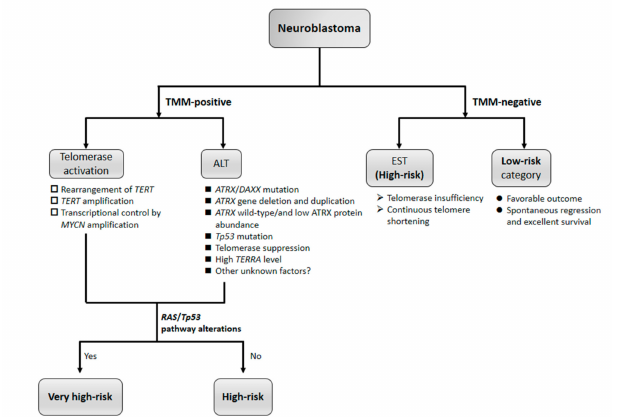
Figure 1. Telomere maintenance mechanisms (TMM) in NB. Presence and absence of TMM and RAS or TP53 pathway alterations define clinical subgroups of NB. Table 1. Incidence of TMM triggered by telomerase and ALT or no TMM in NB from several cohorts of different studies. Study